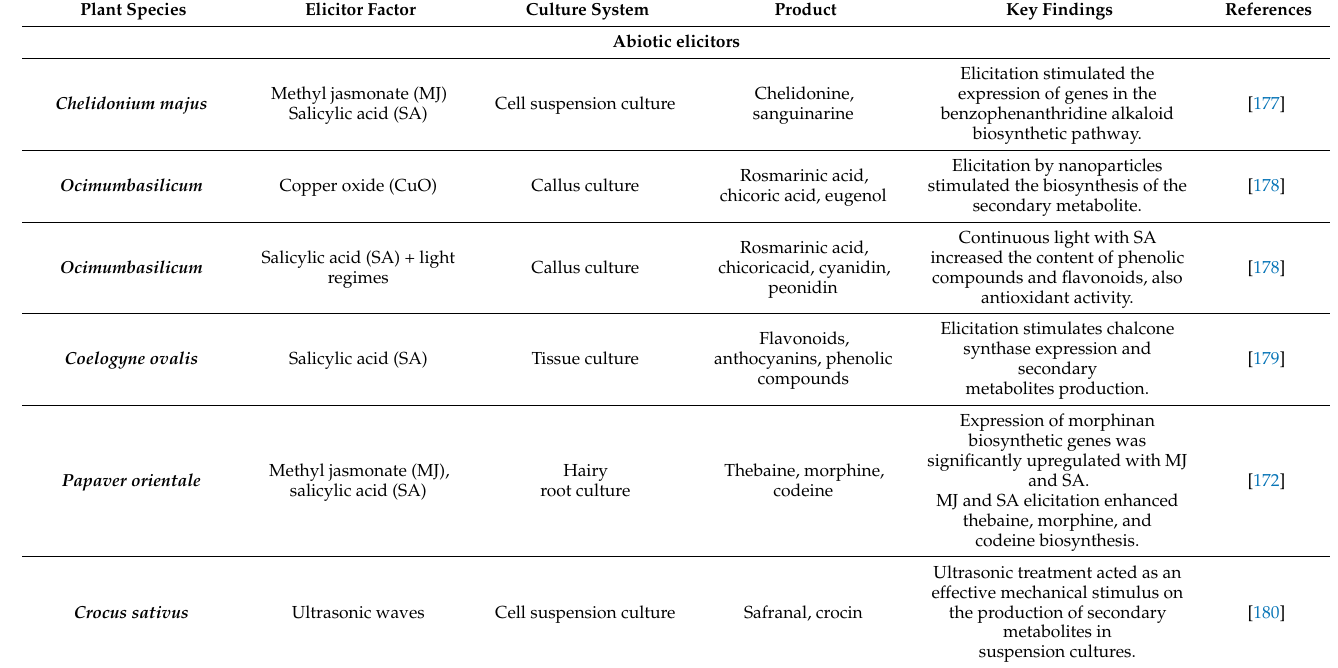
Table 4. Some application of abiotic and biotic elicitors in the production of plant secondary